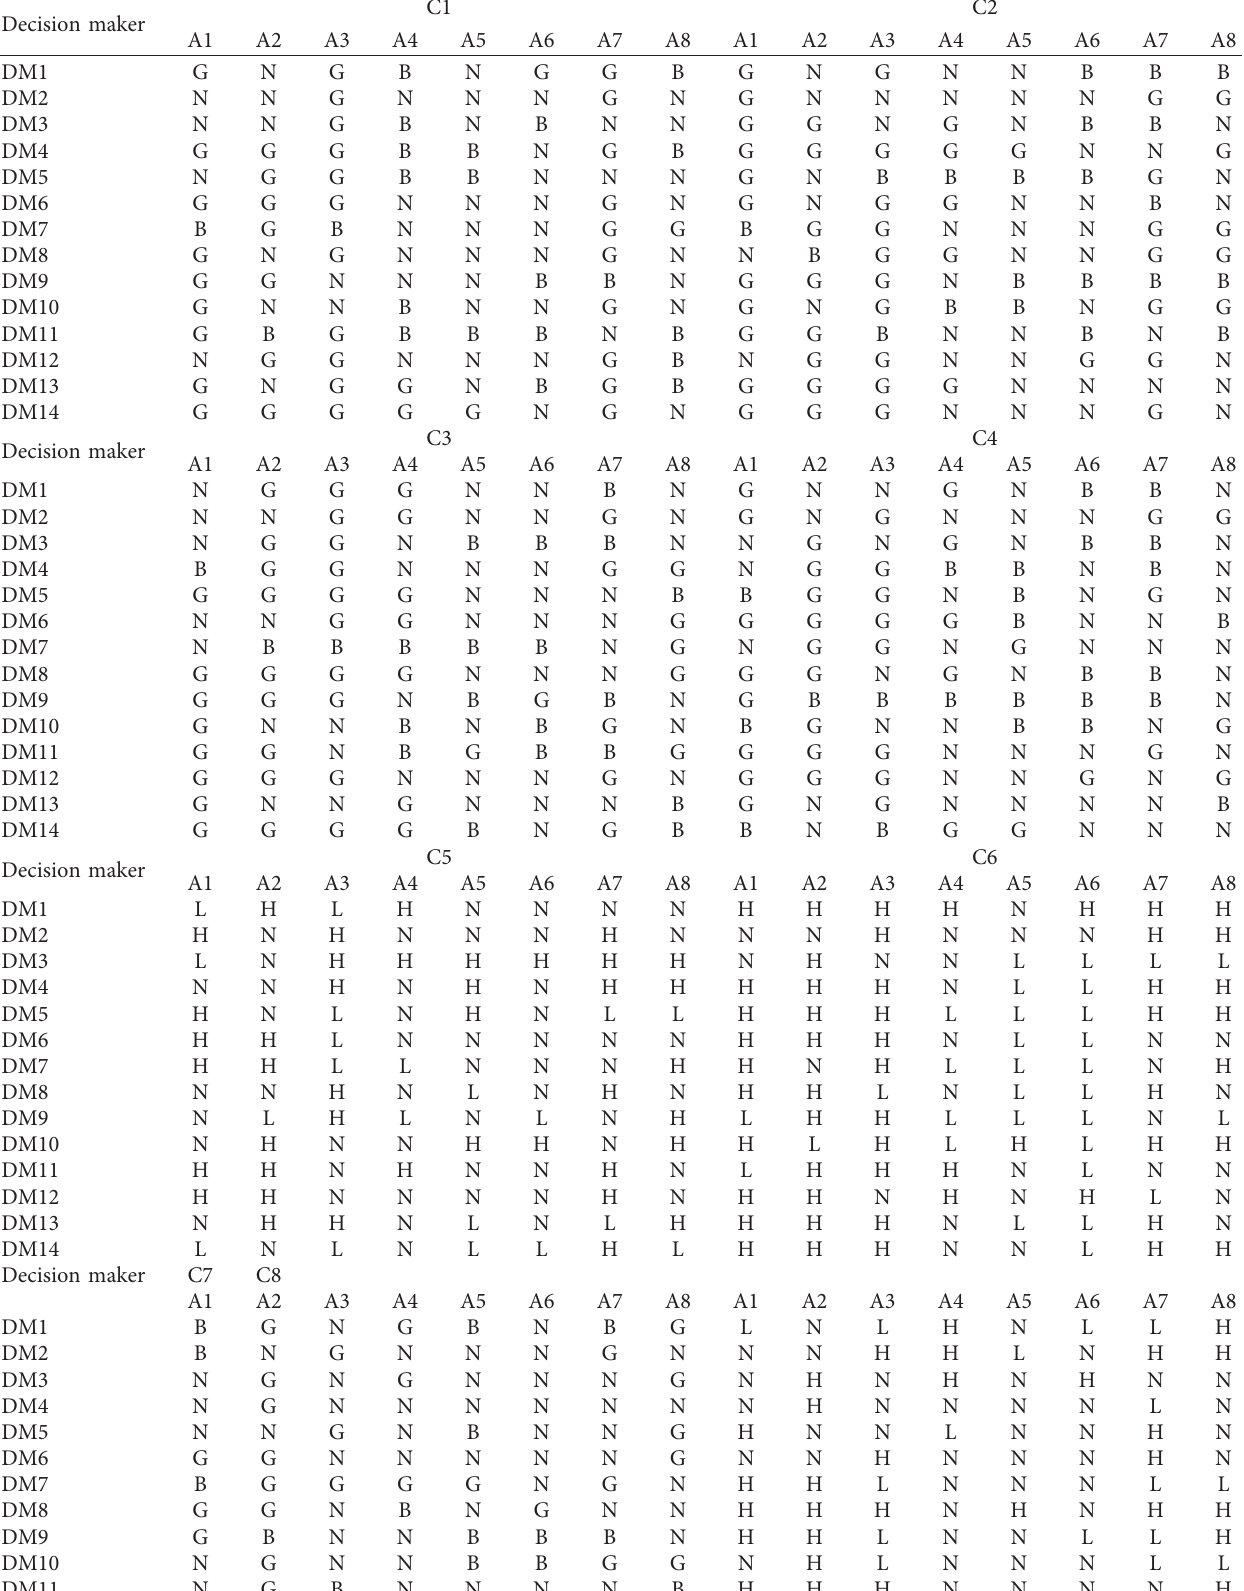
Table 5: Linguistic response matrix for rating the